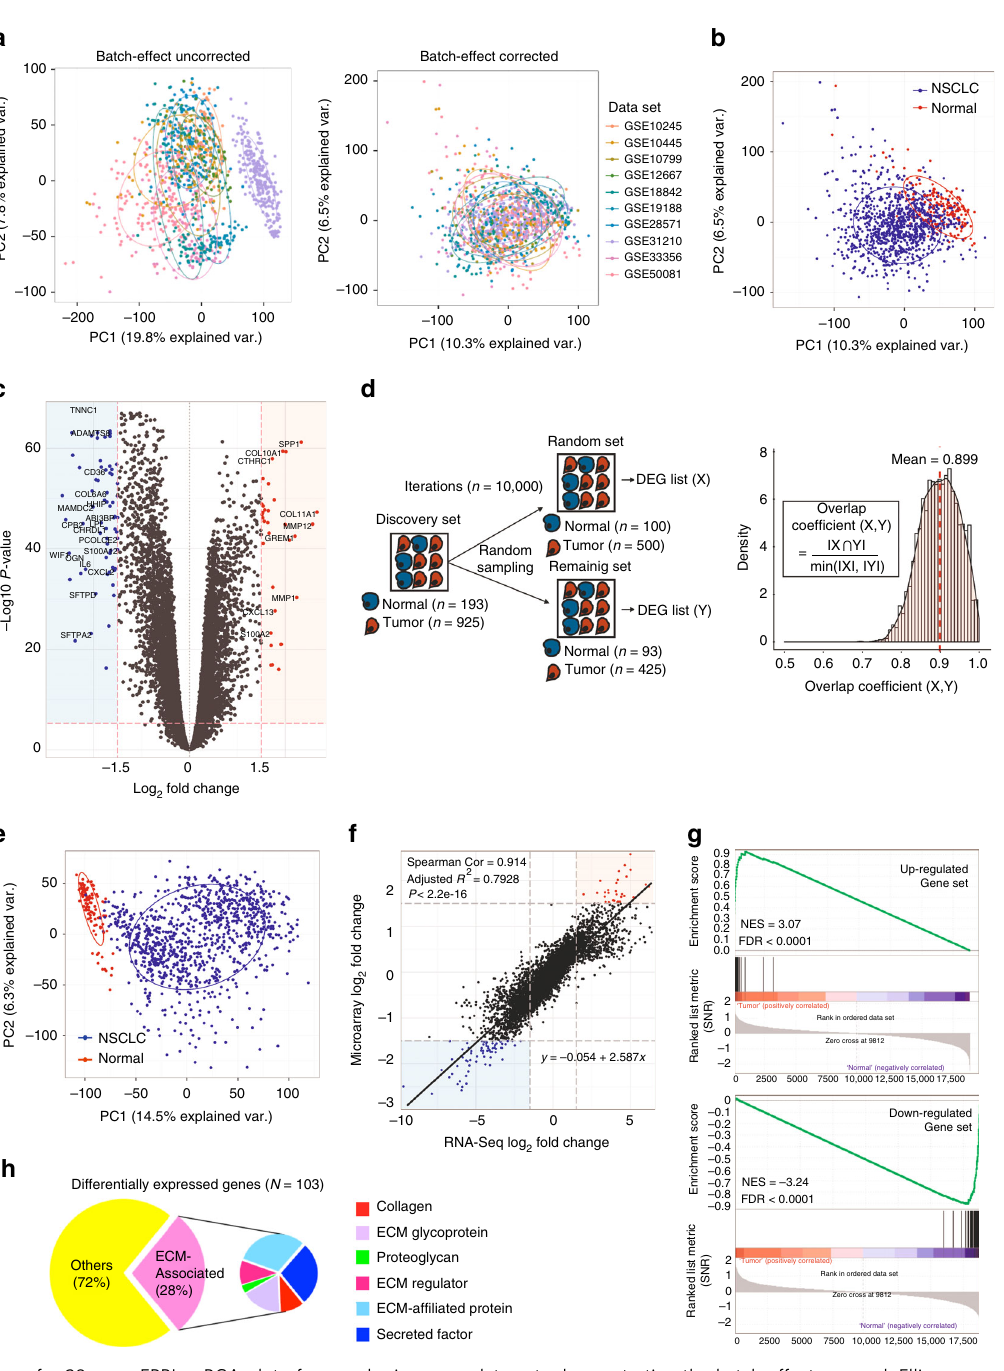
Fig. 2 Construction of a 29-gene EPPI. a PCA plot of merged microarray data sets demonstrating the batch effect removal. Ellipses representing one standard deviation away from the mean of the Gaussian fi tted to each data set. b PCA plot showing a clear separation between 925 primary tumors (blue) and 193 normal lung tissues (red). c Volcano plot of differential gene expression using merged microarray data. Upregulated and downregulated genes with absolute values of log2 fold-change > 1.5 in primary NSCLC tumors are shown in red and blue, respectively. Gray dots represent statistically non-signi fi cant genes. d Schematic representation of random sampling steps for comparing the overlap between DEG lists using merged microarray data sets (left). Kernel density estimates of overlap coef fi cients computed from 10,000 iterations are shown (right). e PCA plot of TCGA data sets (LUAD, LUSC) showing a clear separation between primary 1,018 tumors (blue) and 110 normal lung tissues (red). f Comparison of log 2 fold-change estimate results from two different platforms. Upregulated and downregulated genes are shown in red and blue, respectively. g GSEA-generated enrichment plots of the upregulated and downregulated gene set in a TCGA cohort. The cumulative enrichment score is plotted as the green curve, which is the running sum of the weighted ES as the analysis walks down the ranked list computed from GSEA software. The vertical black lines on the middle portion of the plot indicate the position of inputted gene signatures in the ranked list of genes. Genes on the far left (red) and right (blue) correspond to high enrichment in NSCLC and normal phenotype, respectively. The bottom plot (gray) shows the value of the ranking metric as the computation goes down the list of ranked genes. The normalized enrichment score (NES) and the false discovery rate (FDR) are shown on the graph. h Pie chart of differentially expressed genes annotated with ECM-related molecules and their major categories for ECM